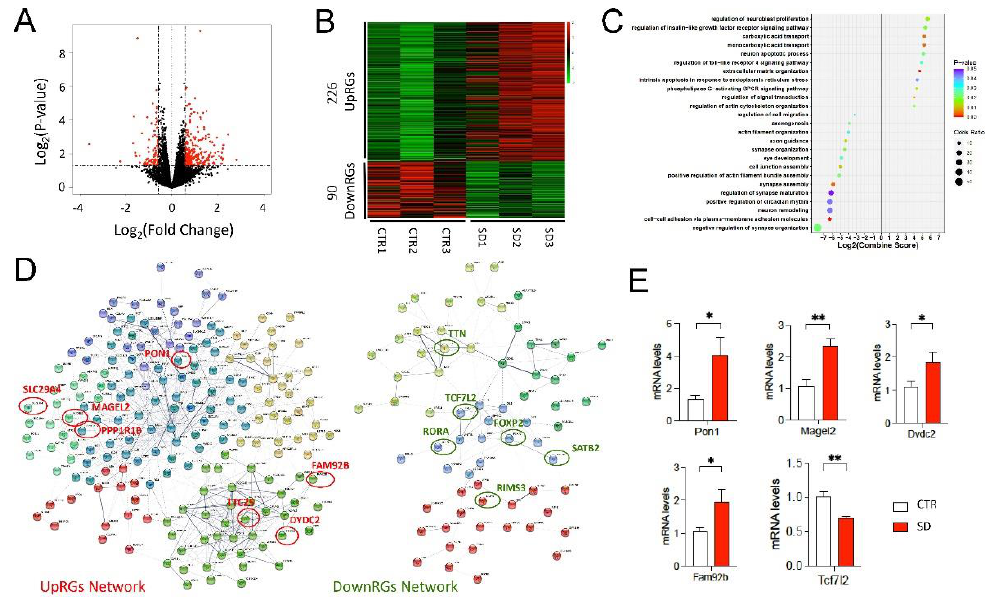
Figure 2. Genome-wide transcriptional changes in the hippocampi of SD mice. ( A ) Volcano plot shows the Log2 (fold-change) and Log2 ( p -value) of the genes. DEGs are highlighted with red color. ( B ) Heatmap shows the Z-scored expression value of identified DEGs. We identified 226 UpRGs and 90 DownRGs in the SD mice. ( C ) Top 25 GO analysis results of DEGs. P-value is indicated by the color of points and the size of points is a proportion of the odds ratio. Negative log2 (combined score) indicates the pathway analyzed from the downregulated gene set. ( D ) DEGs network (protein– protein interaction from STRING v11.5), we found there were 7 upregulated and 6 downregulated genes that are included in the SFARI database. UpRGs are circled in red: slc29a4, magel2, fam92b, pon1, ttc25, dydc2, ppp1r1b; DownRGs are circled in green: satb2, rora, foxp2, rims3, ttn, tcf7l2. ( E ) Validation results of identified SFARI-overlapped DEGs by qRT-PCR. n = 3 in CTR and SD. ** p < 0.01; * p < 0.05 vs. CTR.